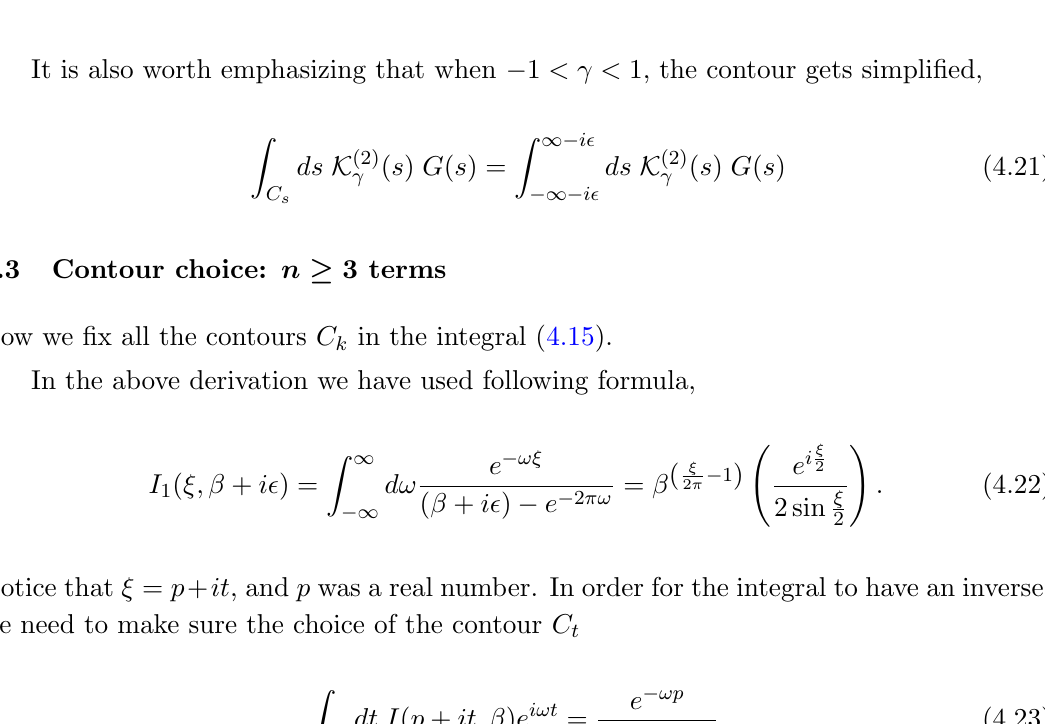
Figure 2 . The contour C s of the integral (4.16)(blue line). Orange dots are the poles s k of the kernel K (2) (cid:13) ( s